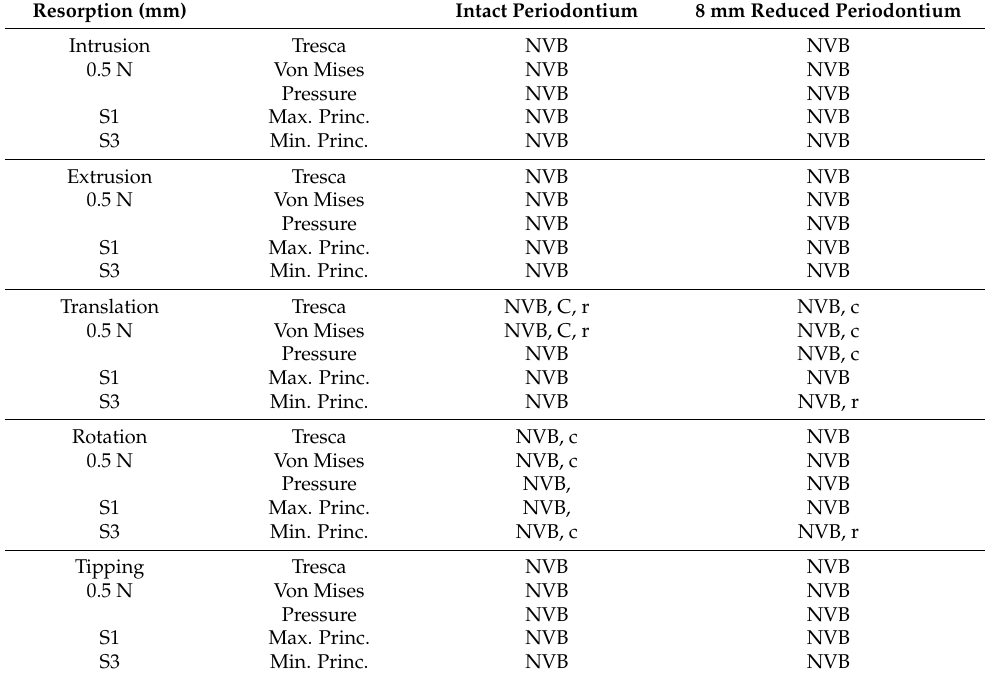
Figure 6. Stress distribution produced by translation movement in the apical NVB and dental pulp of one of the nine models (intact, 4 mm and 8 mm reduced periodontium, vestibular-mesial view) in MPa: ( A )—Tresca, ( B )—Von Mises, ( C )—Pressure, ( D )—Maximum principal, ( E )—Minimum principal. Table 2. Maximum stress average values (KPa) produced by orthodontic forces: NVB- apical neu- Table 3. Color-coded stress projection in apical NVB and dental pulp for different failure rovascular bundle; c-coronal pulp.